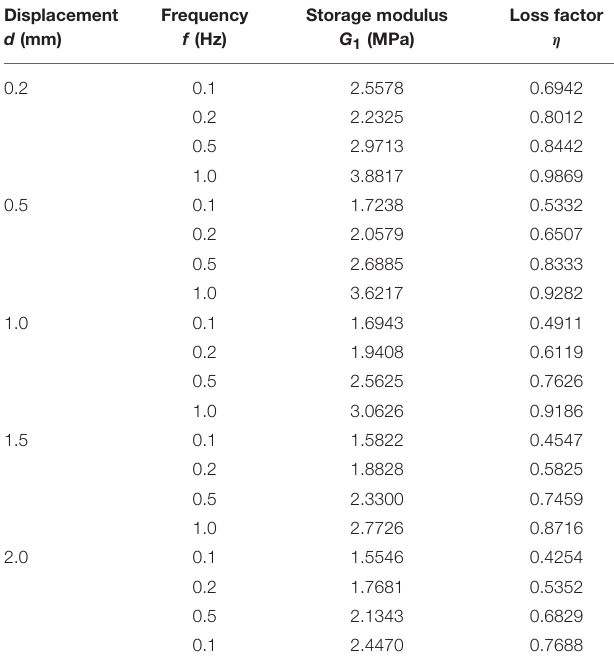
TABLE 2 | Characteristic parameters G 1 , η of the viscoelastic damper. Displacement d